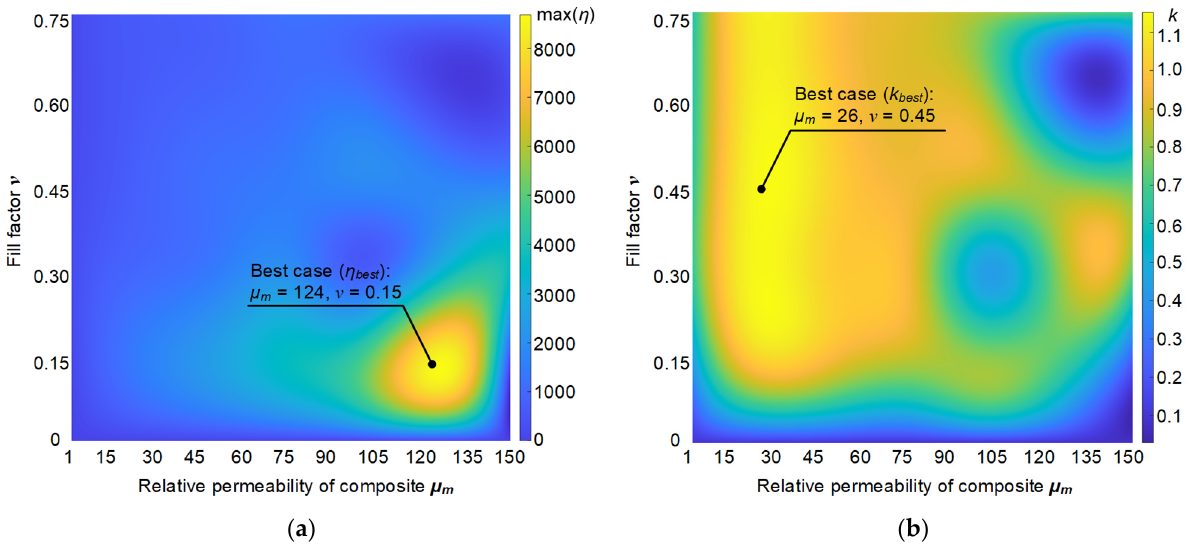
Figure 5. The results of maximizing objective function η = f( C ) for different fill factors ν and permeabilities µ m at f r = 100 kHz: ( a ) energy transfer gain η and ( b ) magnetic field ratio k .